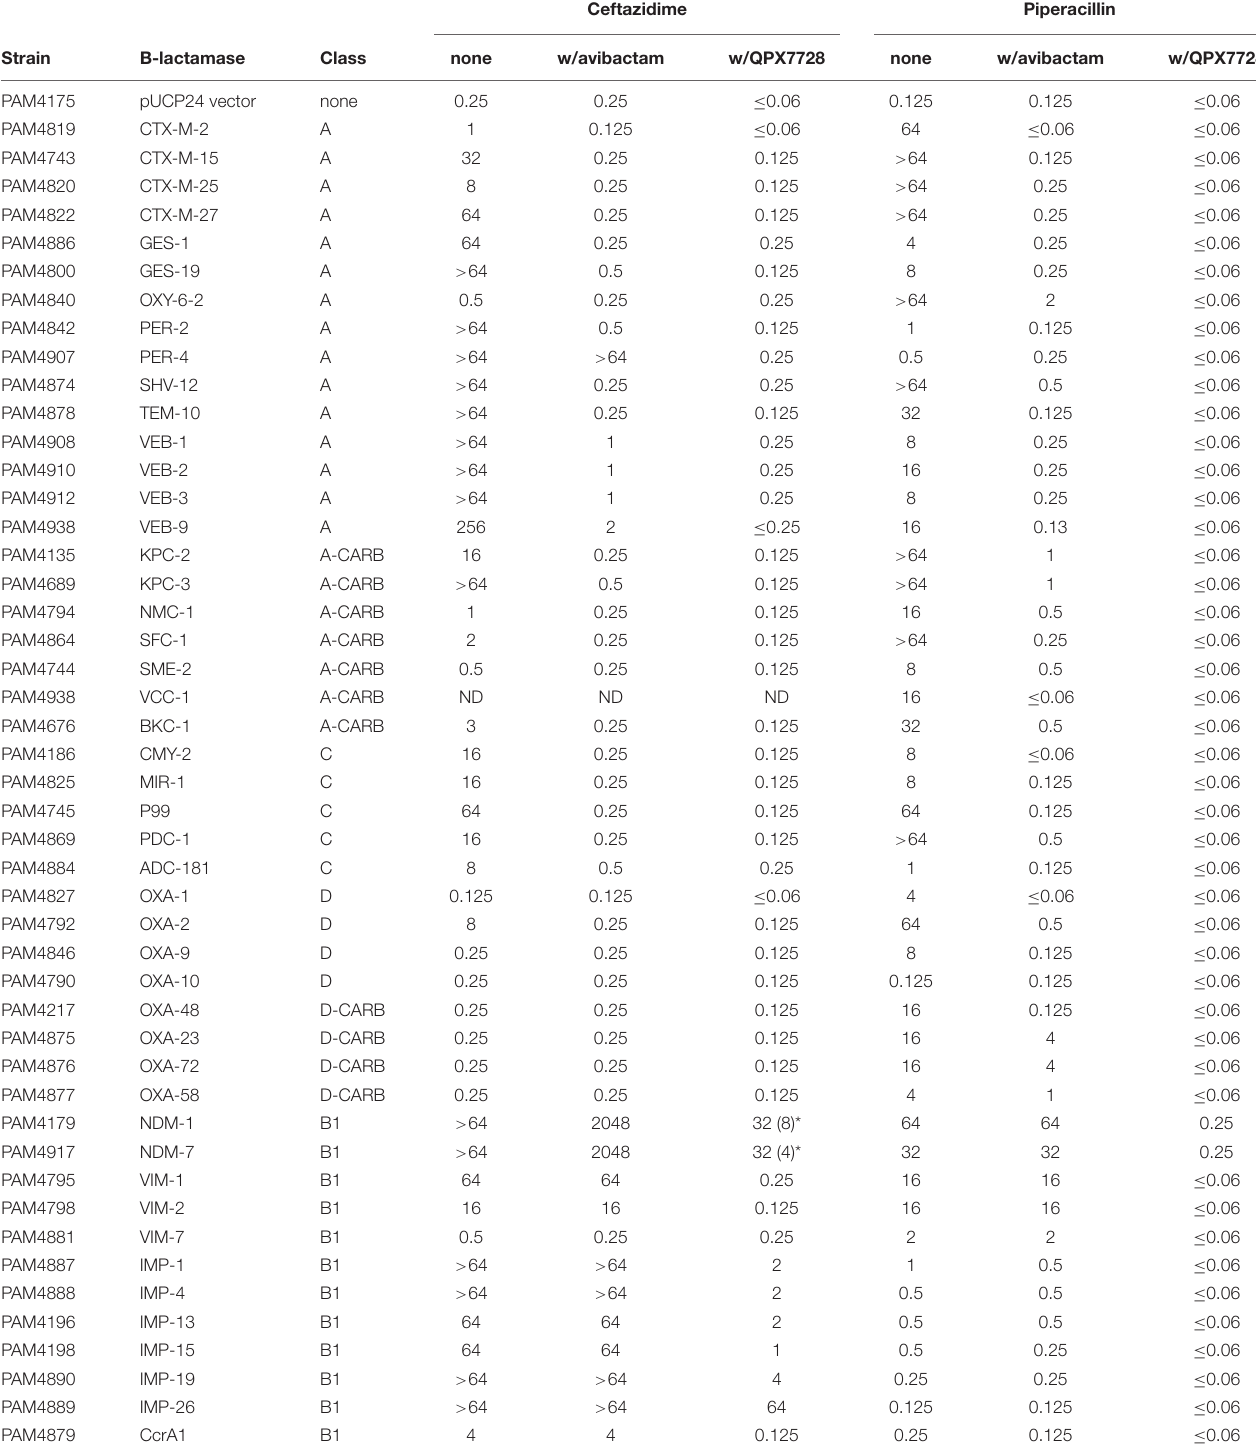
TABLE 2 | In vitro potency (MIC, µ g/ml) of ceftazidime and piperacillin alone and in combination with BLIs against the panel of engineered strains producing single β -lactamases. Ceftazidime